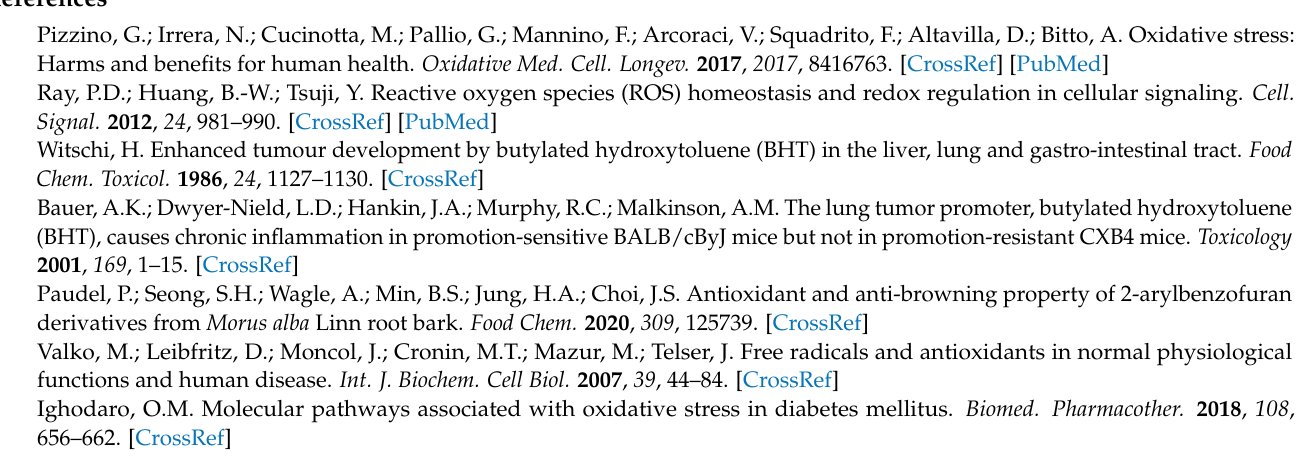
kuwanon H ( 6 ). Figure S7: HPLC chromatogram of isolated pure compounds in reverse phase. Figure S8: Reverse-phase HPLC chromatogram of water extract. Figure S9: Reverse-phase HPLC chromatogram of methanol extract. Figure S10: Reverse-phase HPLC chromatogram of ethanol extract. Figure S11: Reverse-phase HPLC chromatogram of acetone extract. Figure S12: Reverse- phase HPLC chromatogram of ethyl acetate extract. Figure S13: Reverse-phase HPLC chromatogram of dichloromethane extract. Figure S14: Reverse-phase HPLC chromatogram of n -hexane